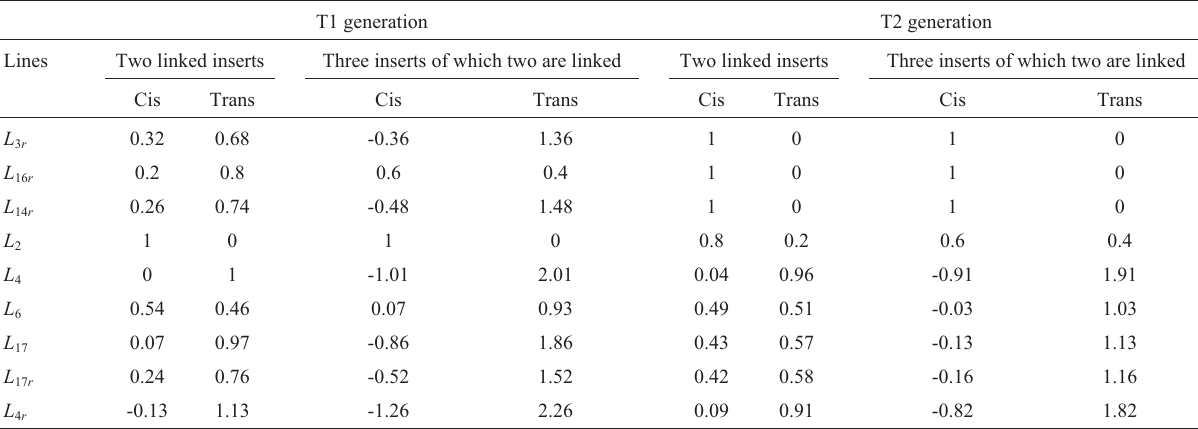
Table 6 - Estimated distances between linked inserts (Morgan) in the T1 and T2 generations. T1